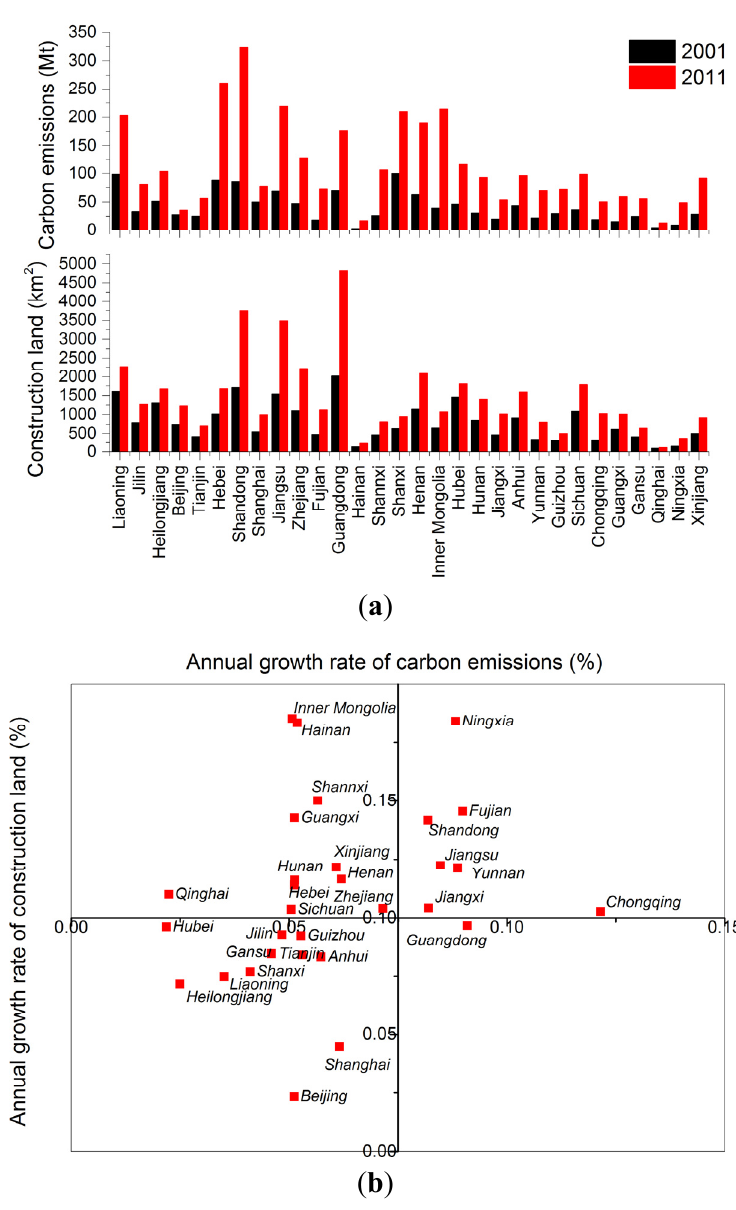
Figure 3. Change characteristics of provincial carbon emissions and construction land from 2001 to 2011. ( a ) Emissions and construction land area; ( b ) Annual growth